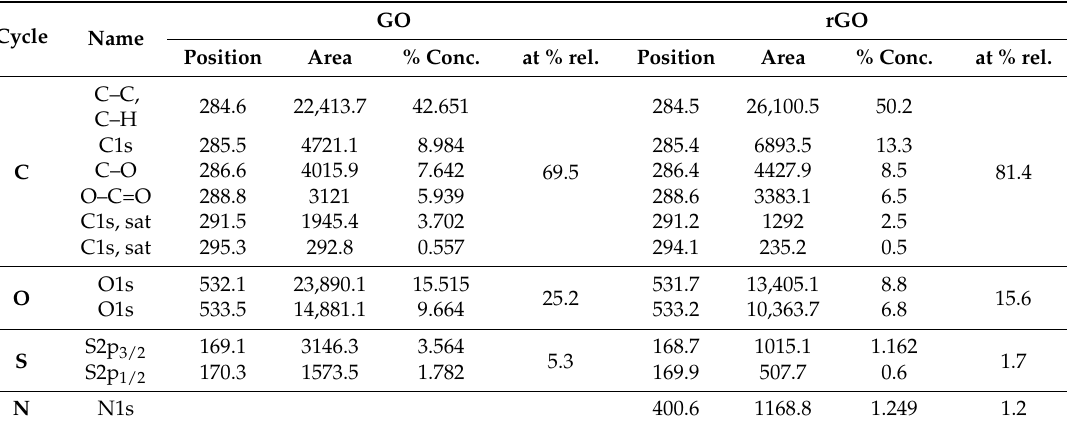
Figure 2. High-resolution XPS spectra of: ( a ) GO and ( b ) rGO. Table 1. XPS data of GO and rGO.